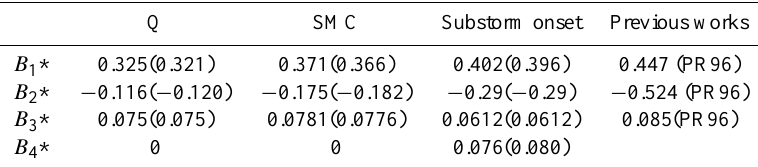
Table 4. Regression models for the tail radius using the terminator models from PR96 and from Shue et al. (1998) (the latter given in